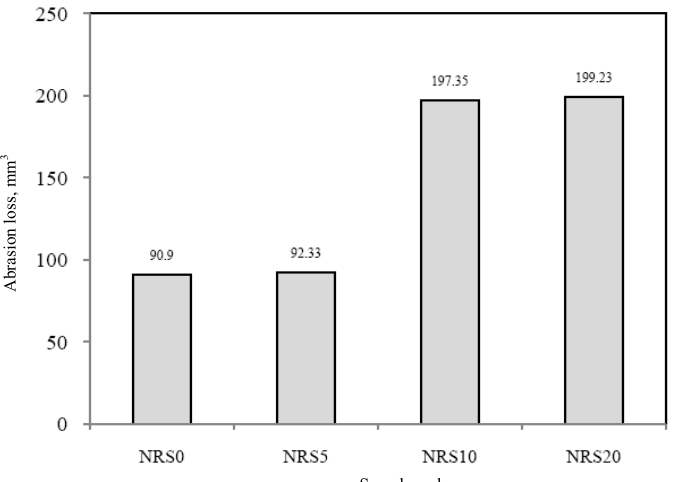
Figure 10. Abrasion loss of samples at various silica